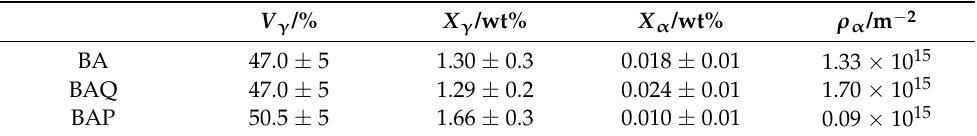
Table 2. Measured data for the BA, BAQ, and BAP samples.